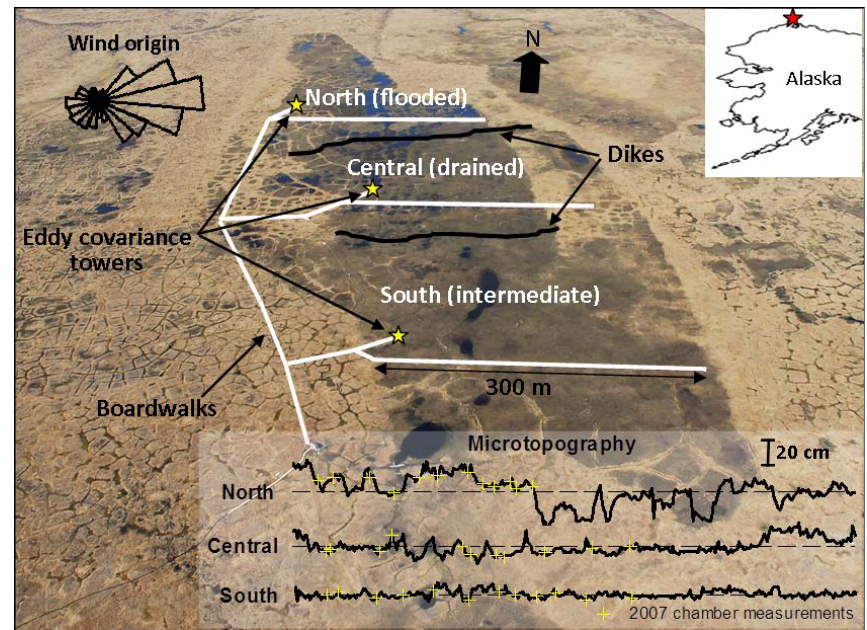
Fig. 1. Oblique aerial view of the Biocomplexity Experiment site. The wind rose in the top left of the image shows the wind direction histogram for the autumn period of 2009 (19 August to 25 October). The lower plots show microtopographical differences along the boardwalks measured by